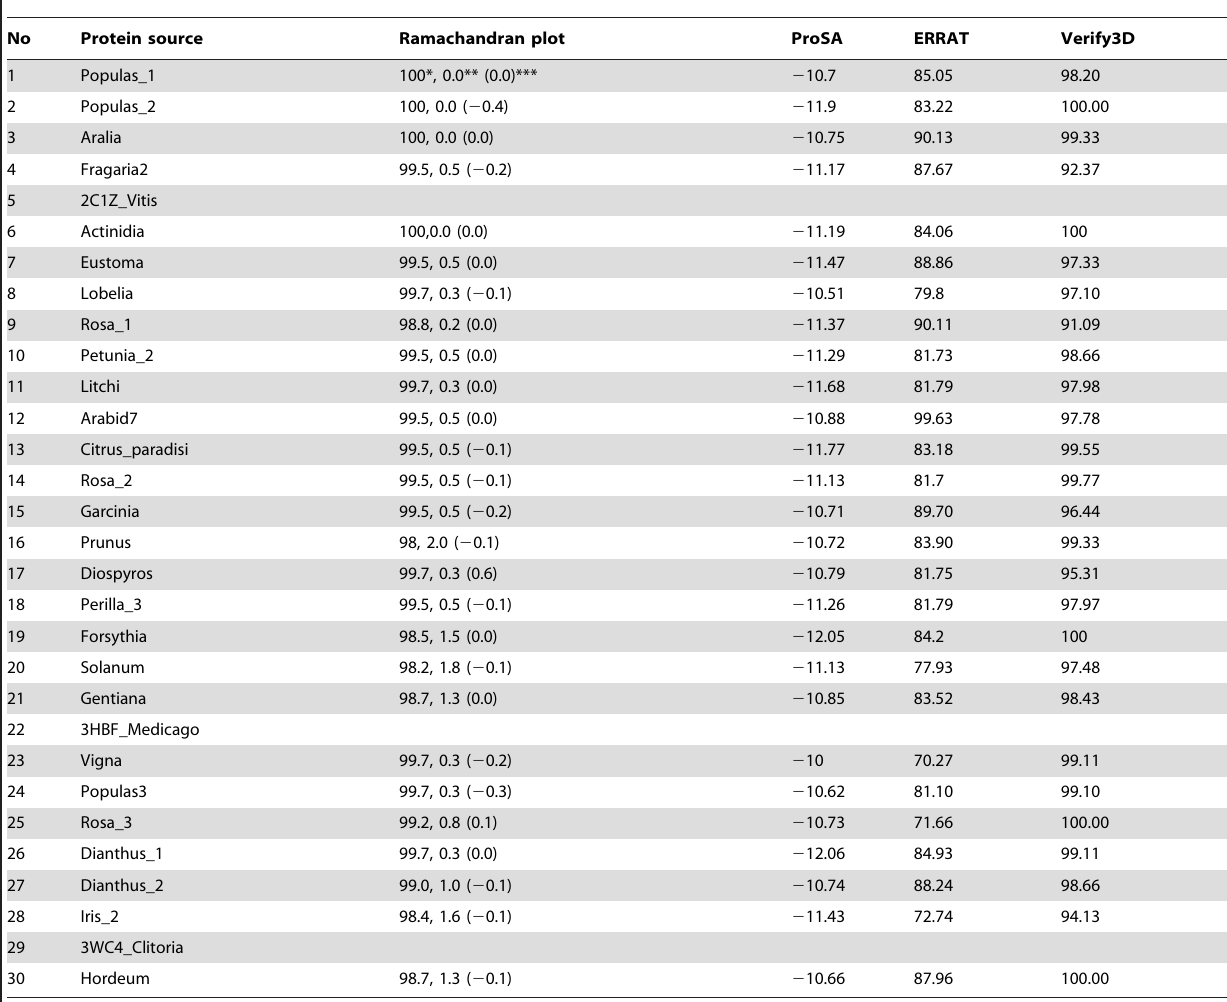
Table 1. Model evaluation statistics of 30 F3GT protein